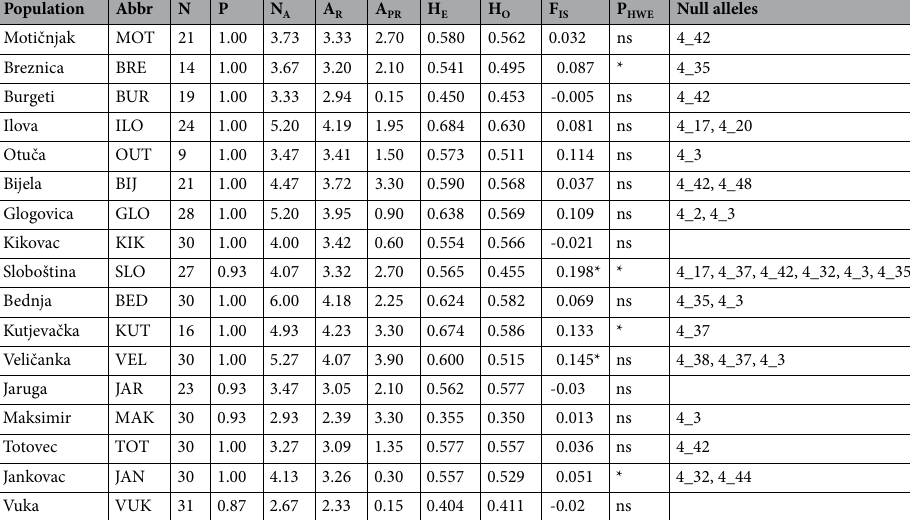
areas of their potential current and future distribution overlap in Croatia using SDM; (3) To combine genetic data from A. astacus with its potential future distribution areas, as well as with future potential distribution of both NICS in order to identify populations and areas of the highest conservation value and priority for protection.